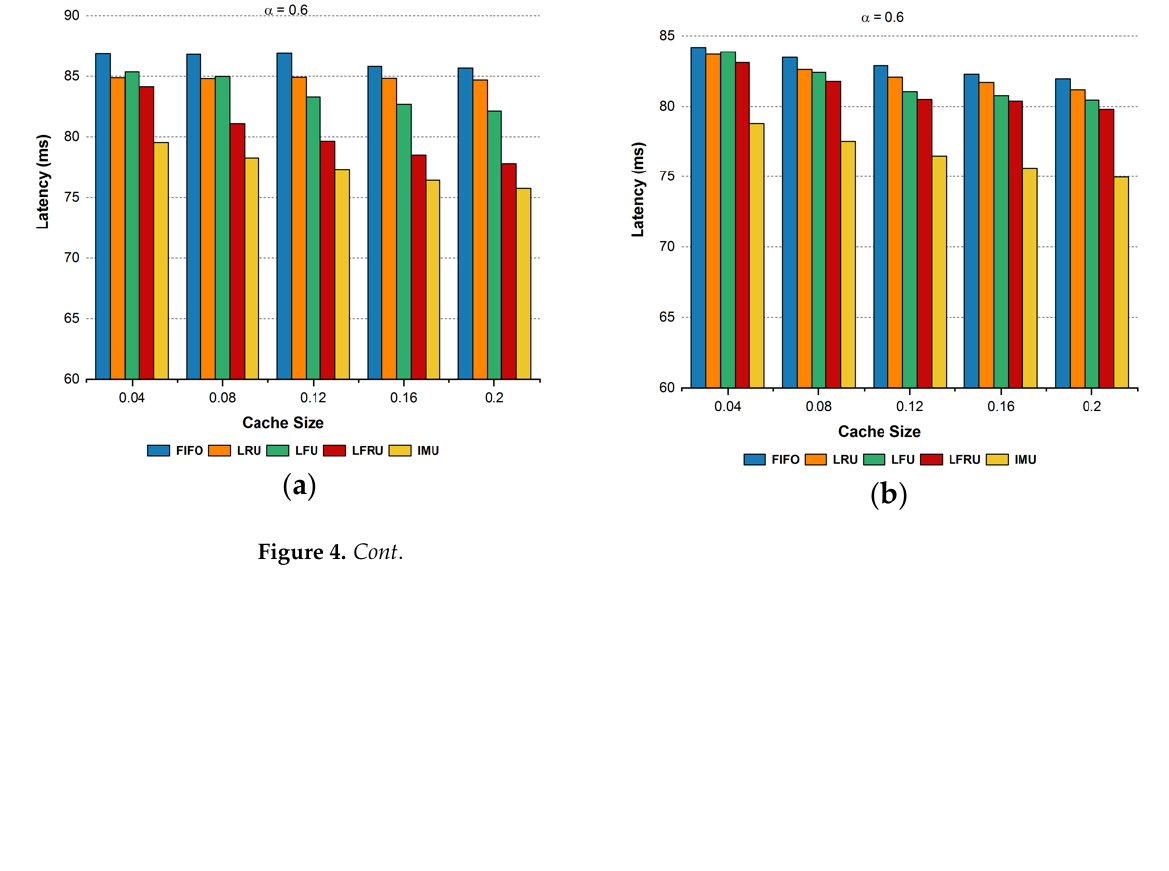
Figure 3. Path stretch with different cache sizes and α , using different placement policies. ( a ) Path stretch with LCE. ( b ) Path stretch with CL4M. ( c ) Path stretch with ProbCache. ( d ) Path stretch with LCD. ( e ) Path stretch with opt-Cache.